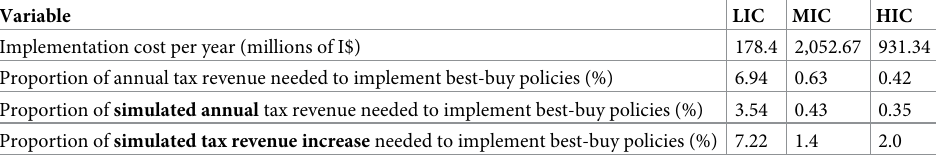
Table 3. Implementation cost per year as a share of annual excise tax revenue, 131 countries